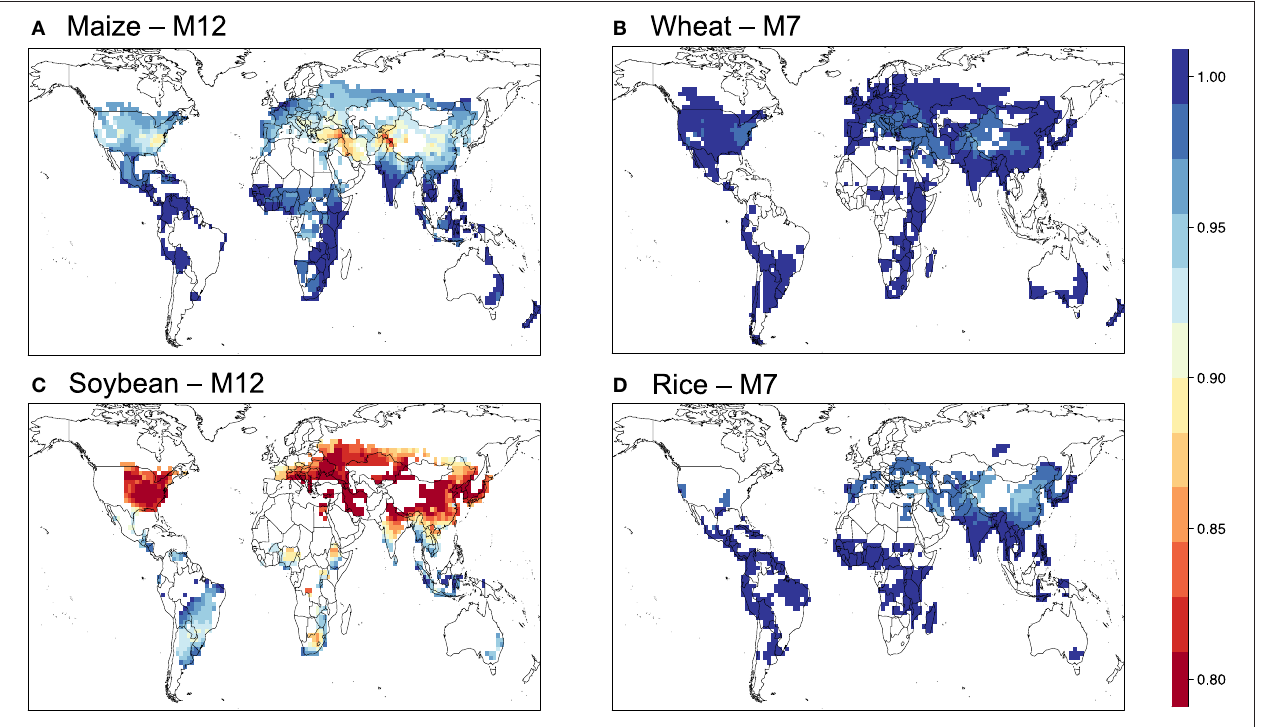
FIGURE 6 | Relative yield based on the M7 or M12 metric for (A) maize, (B) wheat, (C) soybean, and (D) rice.